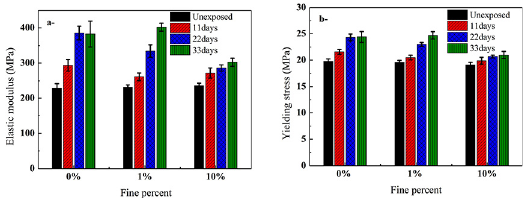
Figure 5. Elastic modulus (a) and yielding stress (b) results of neat UHMWPE and their compounds with iron ore fine after UV